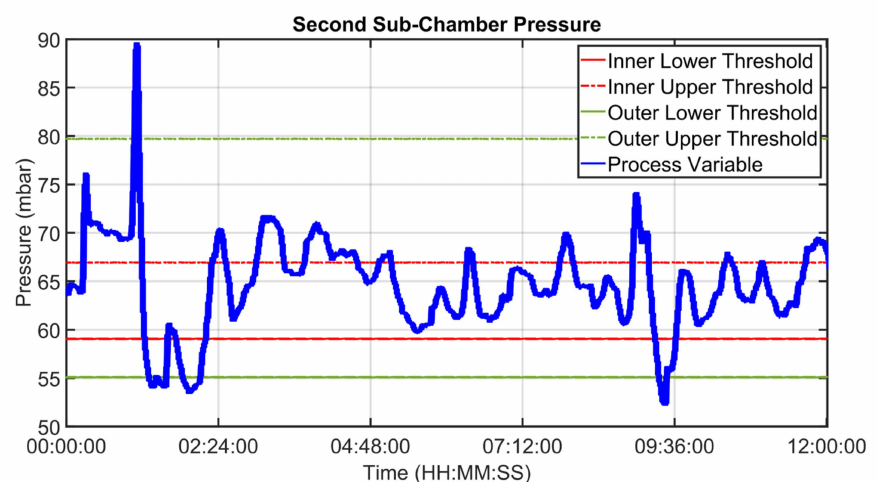
Figure 27. Grate cooler APC system: field results (second sub-chamber pressure